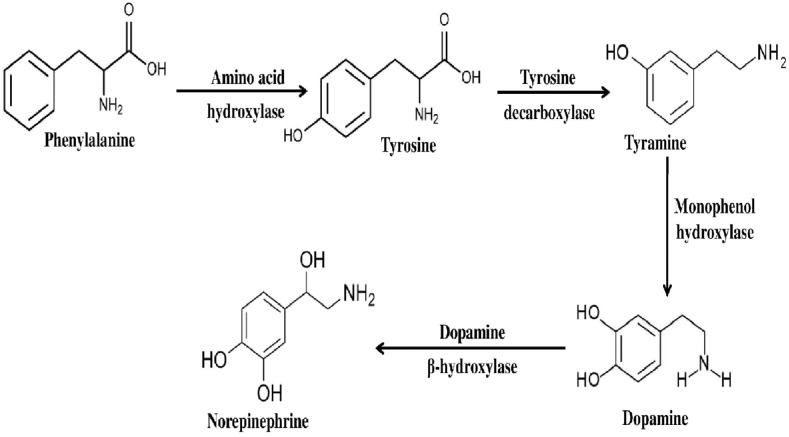
Schematic representation of possible biosynthetic pathway of catecholamines identified in ACL extract.